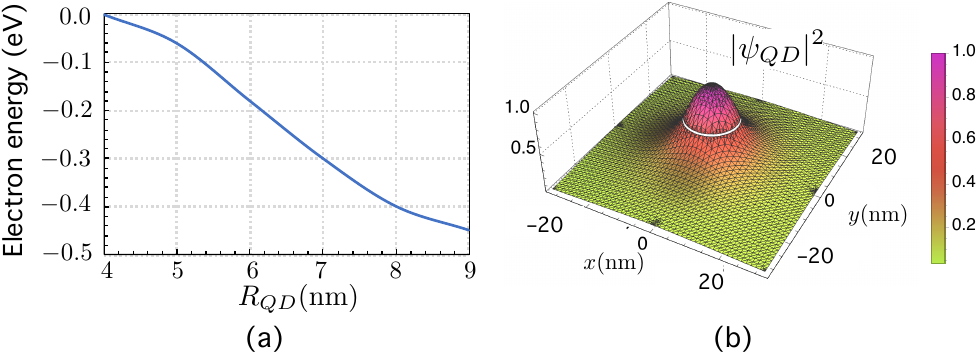
Figure 2. ( a ) Position of the electron energy level (eV) below the CB ( E C = 0 is assumed to be as the energy reference origin) as a function of the quantum dot radius R QD . ( b ) Square modulus of the electron wave function for R QD = 8